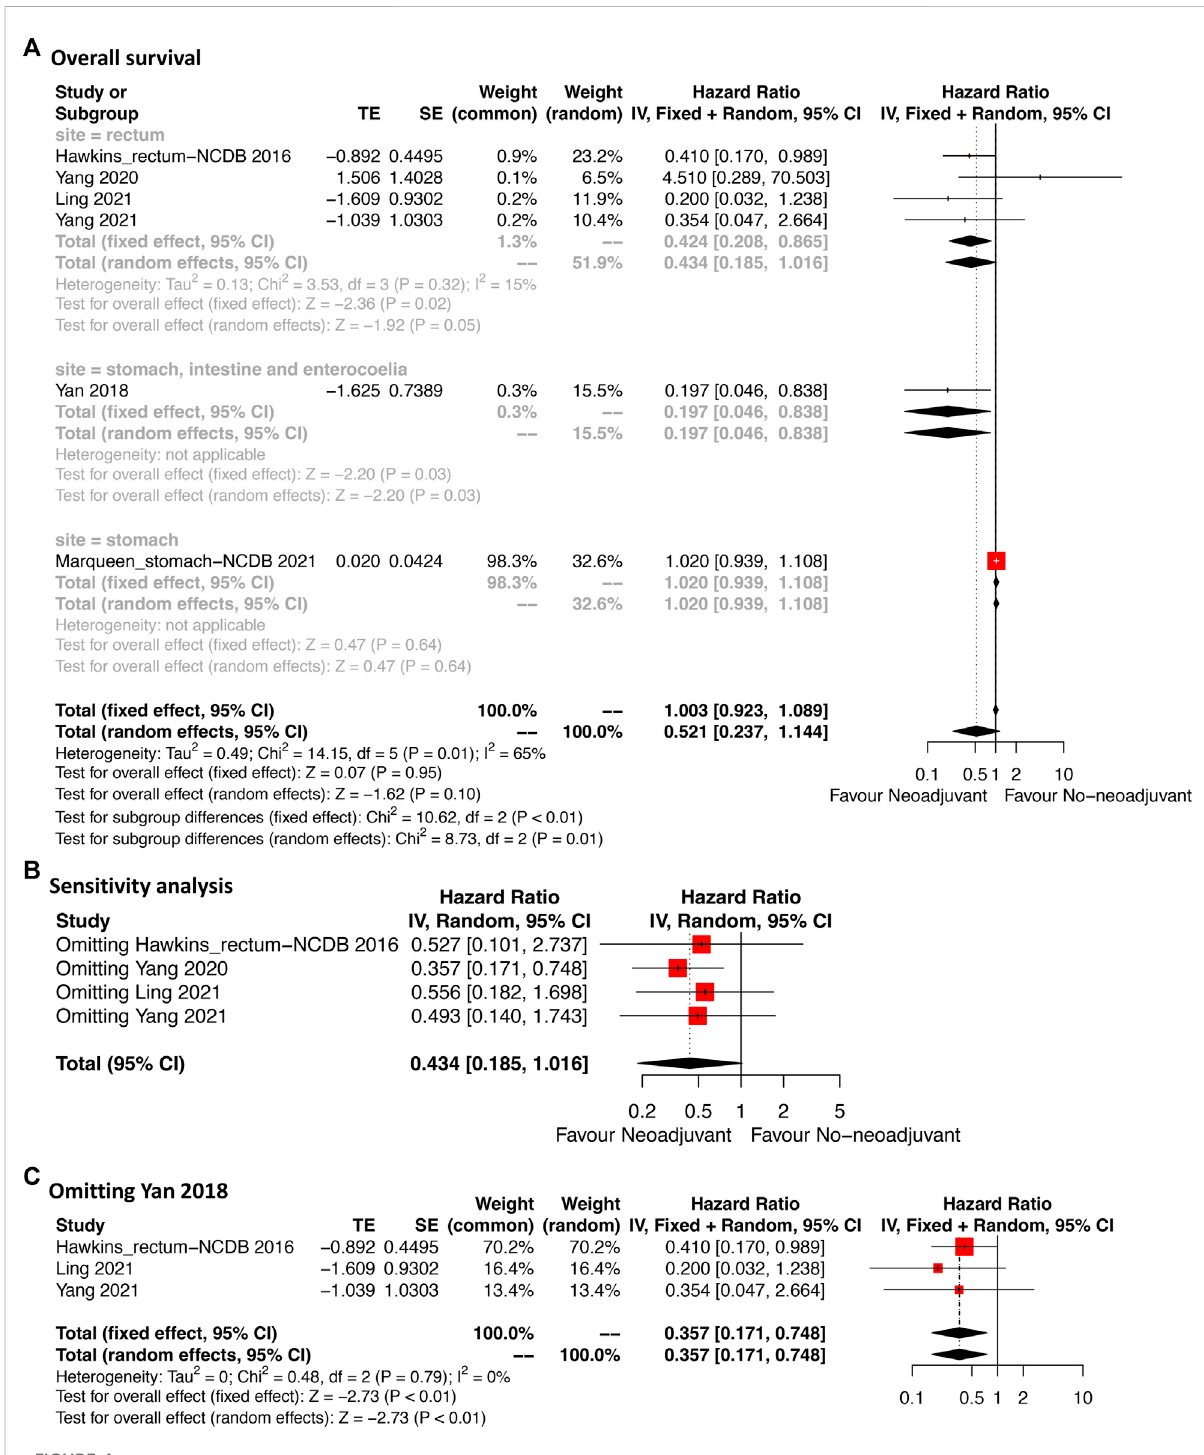
FIGURE 4 Forest plots illustrating overall survival between neoadjuvant and no-neoadjuvant imatinib (A) and sensitivity analyses (B , C) .